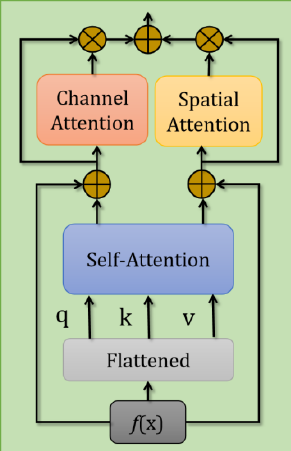
Figure 4. The architecture of the proposed attention module in SiamOT.